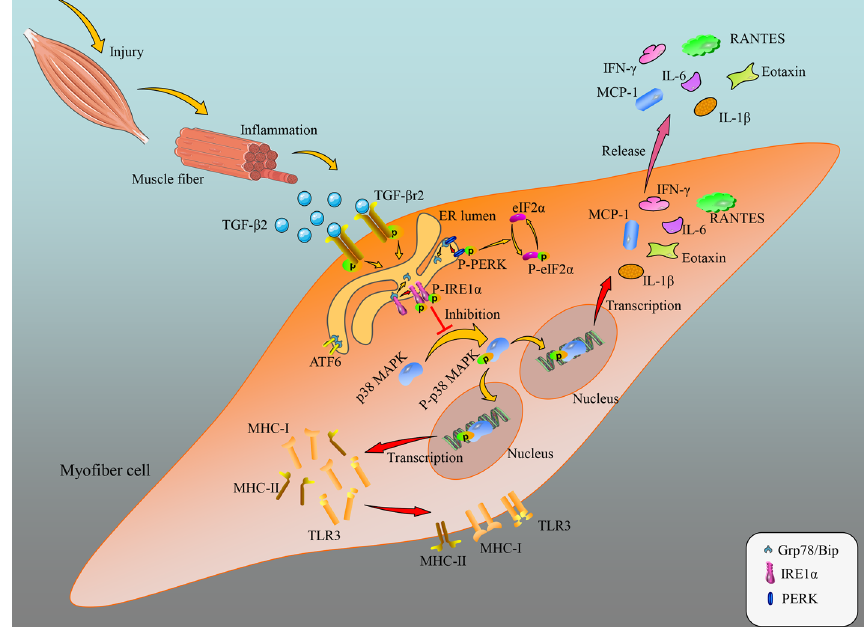
Fig. 11 Proposed model depicting the mechanism by which TGF-β signaling acts as an upstream factor controlling myofiber immune capacities in the inflamed state by the UPR-IRE1α-p38 MAPK